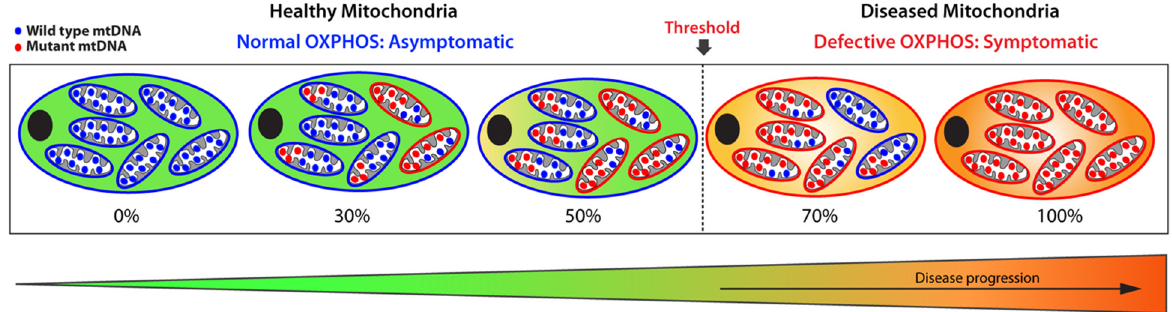
Figure 2. Schematic representation of heteroplasmic threshold. Healthy (functional) mitochondria and wild-type mtDNA are illustrated in blue, while diseased (dysfunctional) mitochondria and mutant mtDNA are shown in red. When a population of diseased mitochondria is below a cell-specific heteroplasmic threshold, it ensures normal overall OXPHOS activity and, therefore, an asymptomatic status. Conversely, when the population of diseased mitochondria exceeds the heteroplasmic threshold tolerated by a cell, it results in defective OXPHOS, giving rise to a symptomatic status. Thus, mitochondrial heteroplasmy modulates disease progression.